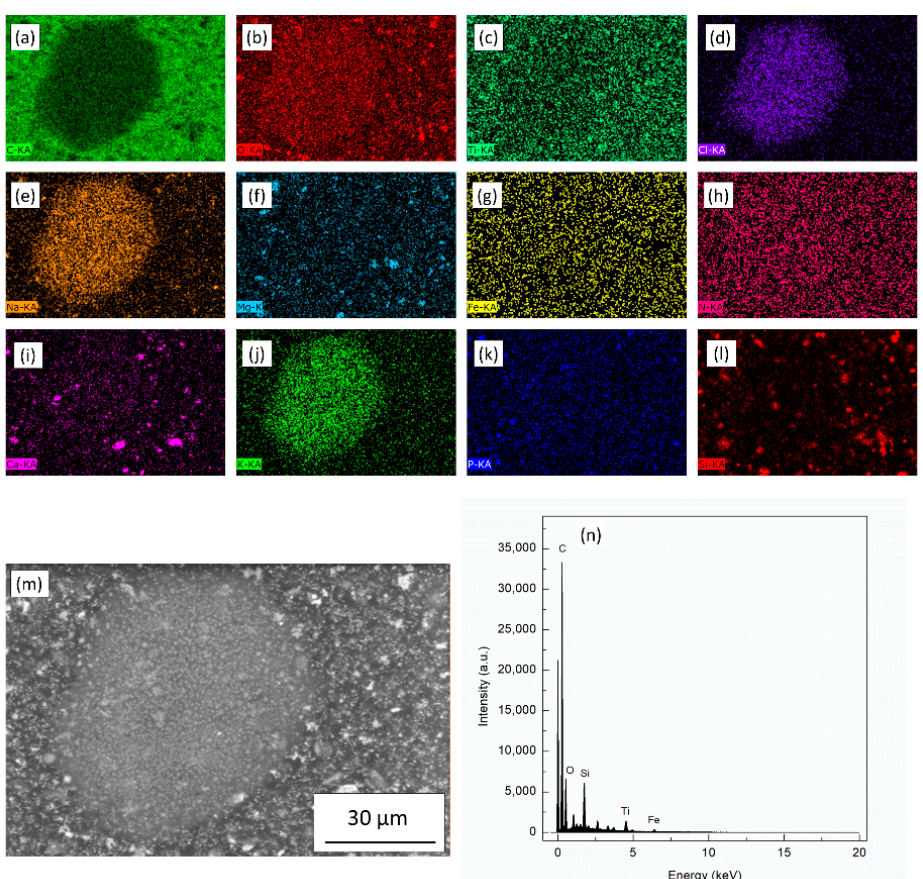
Figure 3. EDX mapping for ( a ) carbon, ( b ) oxygen, ( c ) titanium, ( d ) chlorine, ( e ) sodium, ( f ) magnesium, ( g ) iron, ( h ) nitrogen, ( i ) calcium, ( j ) potassium, ( k ) phosphorus, and ( l ) silicon for the epoxy coating on carbon steel plates containing colophony microcapsules. The SEM micrograph ( m ) displays the area analyzed and the spectrum with major peaks is shown in ( n ).